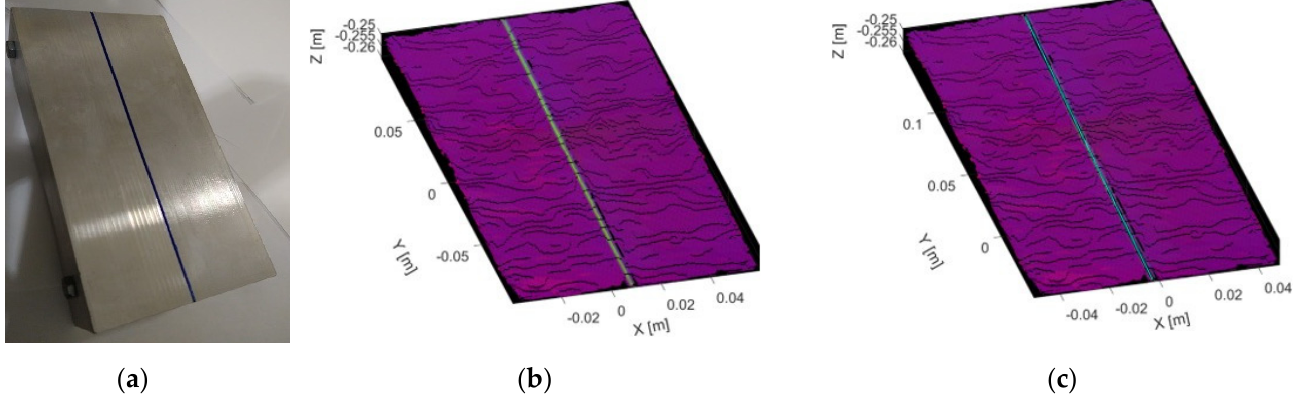
Figure 10. Straight butt joint trajectory extraction: ( a ) workpiece; ( b ) point cloud with HSV data; ( c ) surface with the computed path.